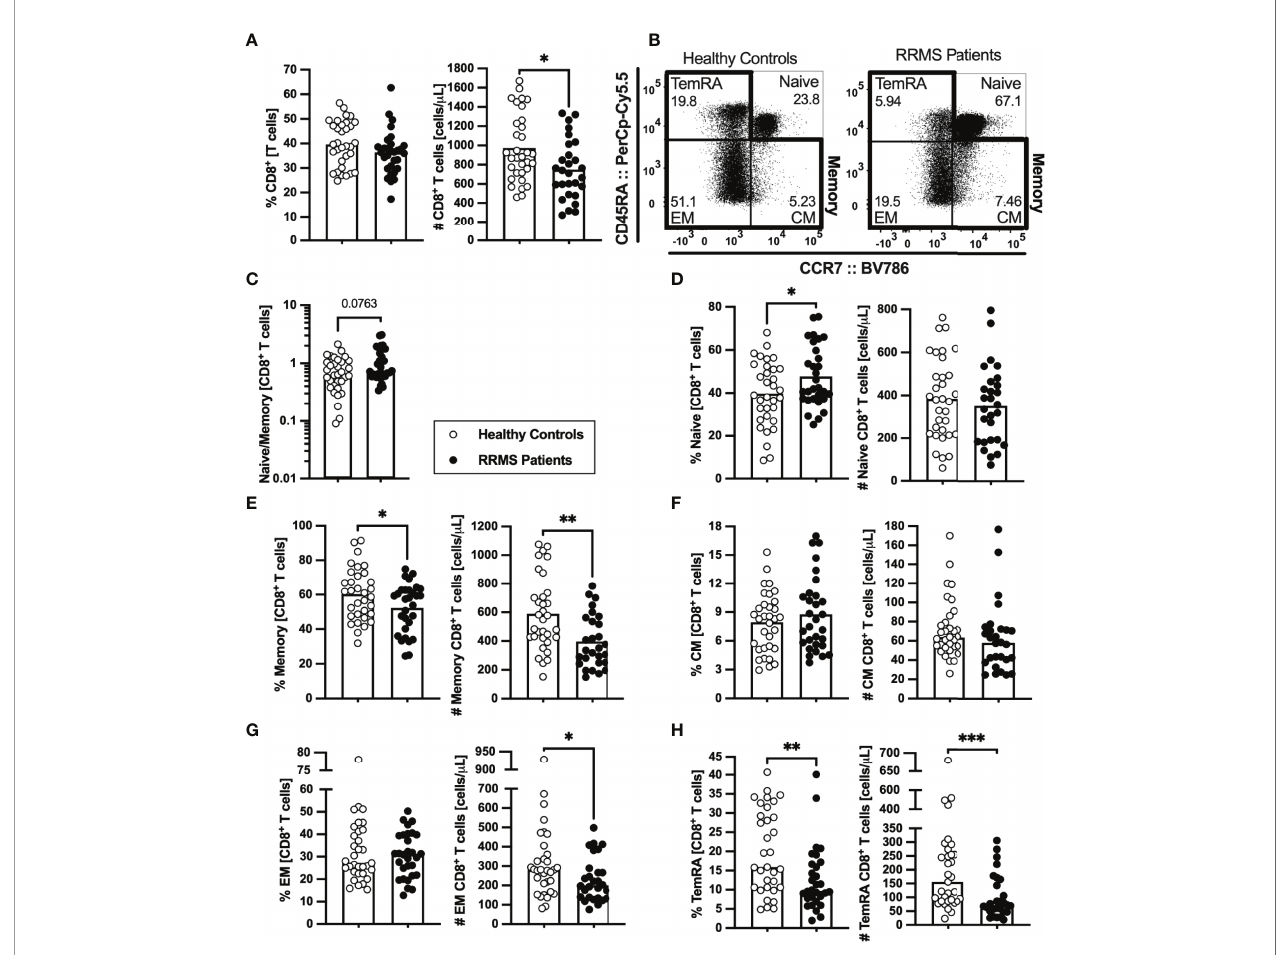
FIGURE 3 | Newly diagnosed RRMS patients have lower numbers of memory CD8 + T cells and consequent higher naïve to memory ratio. Percentages and numbers of CD8 + T cells are represented for healthy controls (white circles) and newly diagnosed RRMS patients (black circles; (A) . Representative dot plots of the CD8 + T cell subpopulations (B) : naïve (CD45RA + CCR7 + ); central memory (CM; CD45RA - CCR7 + ), effector memory (EM; CD45RA - CCR7 - ); and terminally differentiated CD45RA- expressing memory T cells [TemRA; CD45RA + CCR7 − ). Total memory CD8 + T cells are the sum of the CM, EM, and TemRA subpopulations. Naïve to memory ratio of CD8 + T cells (C) . Percentages and numbers of CD8 + T cell subpopulations: naïve (D) , total memory (E) , central memory (F) , effector memory (G) , and TemRA (H) . The parametric Student ’ s t- test was performed in (A ; number), (D, E) , ( F ; percentage); the non-parametric Mann – Whitney U -test in (A ; percentage), (C) , ( F ; number), and (G, H) . Statistical outputs and effect size calculations in eTable 1 . In all graphs, each dot represents one individual, and the horizontal lines represent the groups ’ means or medians depending on the normal or non-normal distribution of the data, respectively. When differences were statistically signi fi cant ( p-value < 0.050), the p -value was represented by * for 0.010 < p < 0.050; **0.001 < p ≤ 0.010; and *** p ≤ 0.001. Results are maintained upon controlling for sex, age, and human cytomegalovirus IgG seroprevalence on multiple linear regression models ( eTable 5